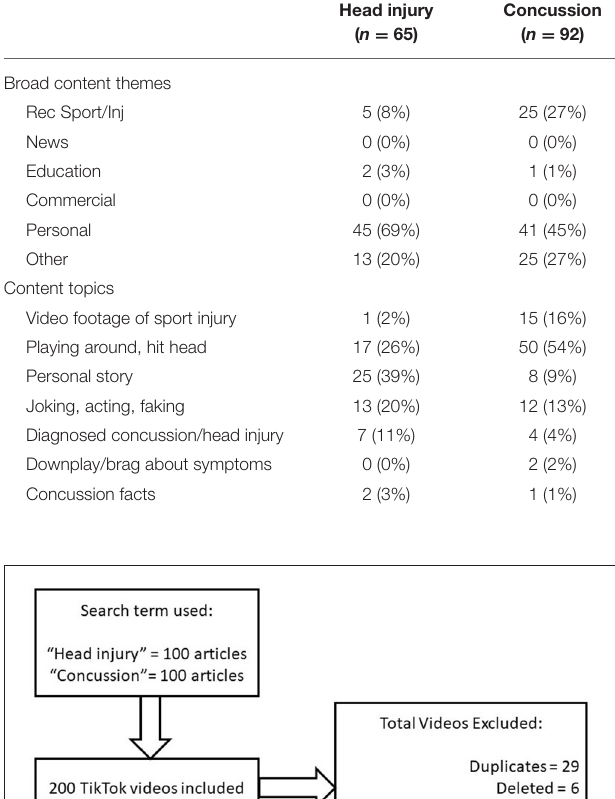
TABLE 3 | TikTok video content themes and topics (tallied and reported as percentage of total).